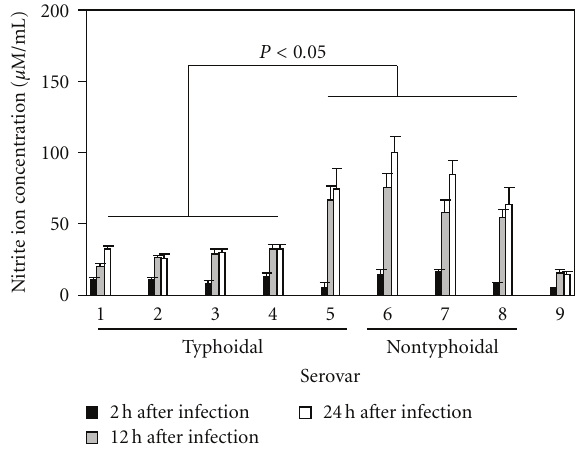
Figure 5: Nitrite ion production by J774 cells cultured with dif- ferent typhoid-causing or non-typhoid-causing Salmonella serovars and co-cultured with IFN- γ . 1: S. typhimurium 14028; 2: S. typhimurium 4/74; 3: S. enteritidis KMS 1977; 4: S. dublin 2229; 5: S. choleraesuis A50; 6: S. kedougou GP; 7: S. montevideo KMS; 8: S. gallinarum ; 9: uninfected cells. All experiments were replicated 3 times on at least 5 separate occasions. Statistical bars show significant di ff erent ( P < 0.05) between nitrite ion production in macrophages infected with typhoidal and nontyphoidal serovars.